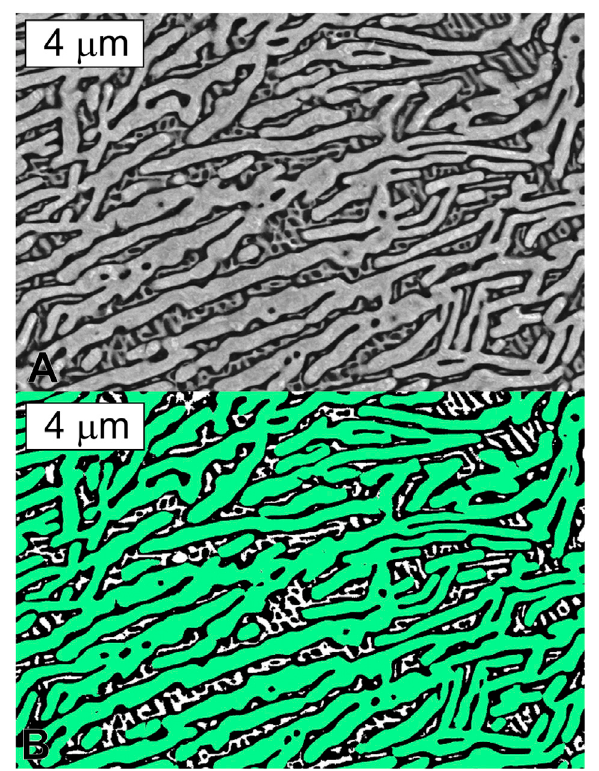
FIGURE 2 | SEM micrograph [backscattered electrons mode (BSE)] (A) and image segmentation (B) for phase analysis using the software ImageJ; segmented image colors: green — face-centered cubic (FCC), white — body- centered cubic (BCC)(A2), and black — BCC(B2).